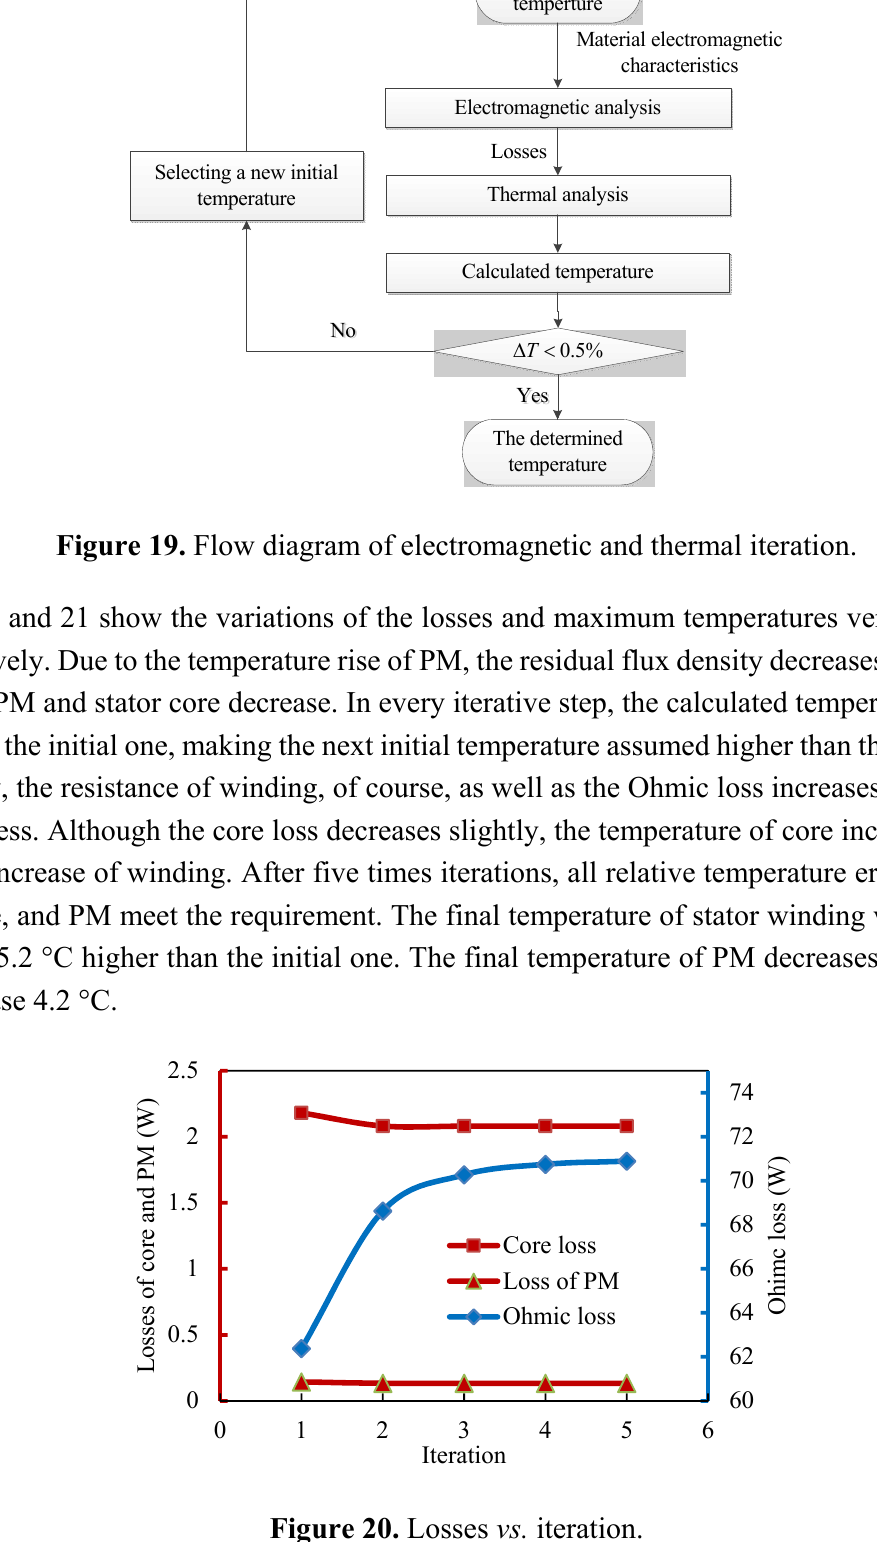
Figure 20. Losses vs.